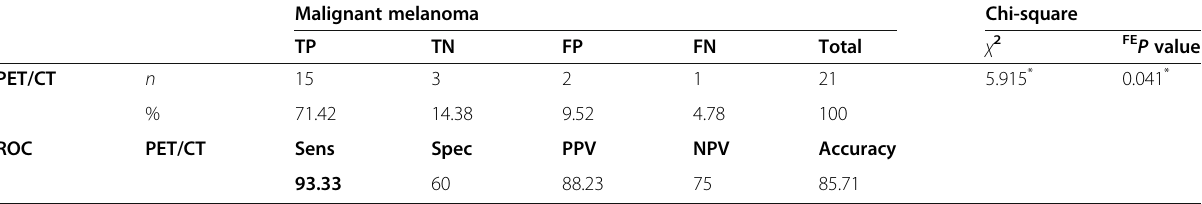
Table 2 Sensitivity (Sens), specificity (Spec), accuracy, PPV, and NPV of PET/CT in initial staging in 21 malignant melanoma cases Malignant melanoma